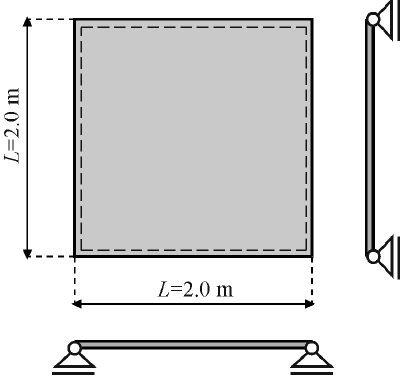
Figure 9. Geometry of the plate.